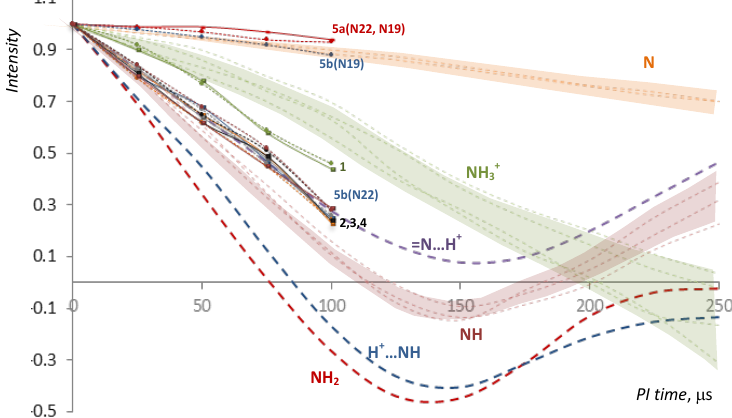
Figure 4. 15 N cross-polarization polarization-inversion profiles. Dots and thin solid lines represent polarization-inversion profiles determined for nitrogen sites N19 and N22 of investigated compounds 4a (R = H), 4b (R = 2-F), 4c (R = 4-F), 4d (R = 2-OCH 3 ), 3e (R = 4-OCH 3 , base), 4e (R = 4-OCH 3 , eq. HCl) and 5e (R = 4-OCH 3 , excess HCl). Thick solid lines represent PI profiles determined for nitrogen moieties (N, NH, =N…H + , NH 2 , NH…H + and NH 3+ ) of model compounds L -His, L -His·HCl·H 2 O, L -Gln, L -Pro and dopamine·HCl.